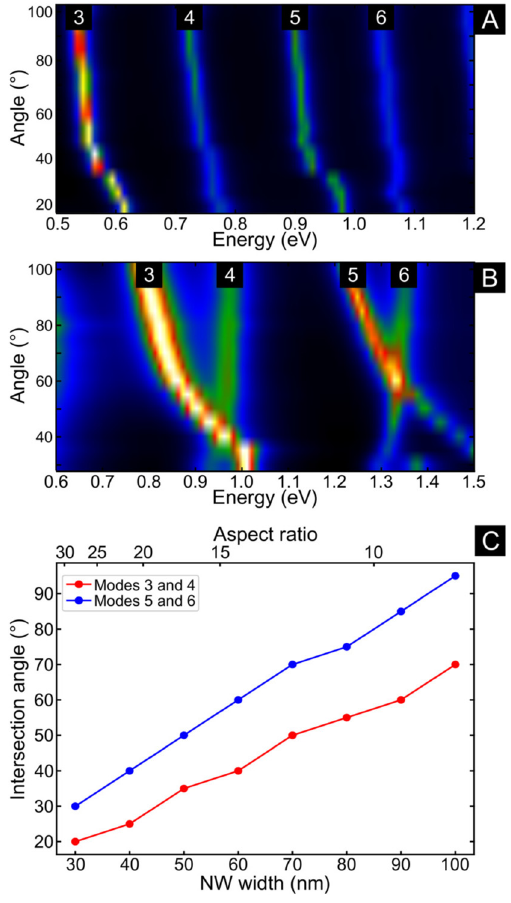
Figure 4: Simulated EEL spectra as a function of bending angle for NWs 850 nm long and with 20 nm (A), and 60 nm (B) width (42.5 and 14.2 aspect ratio, respectively). (C) shows how the intersection angle changes as a function of NW width and aspect ratio for modes 3–4 and